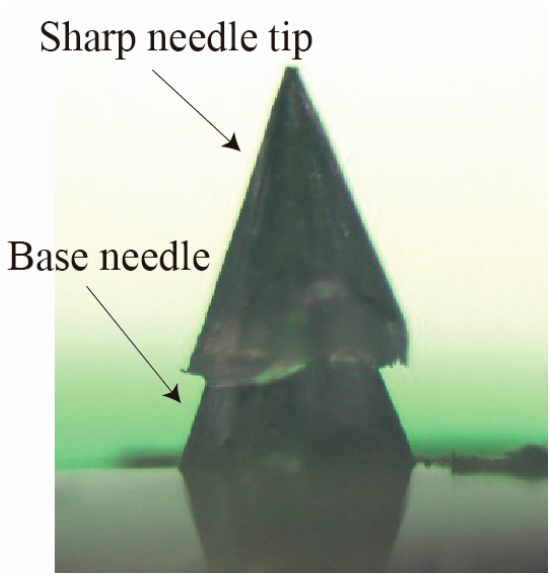
Figure 4. Produced tip-separable microneedle device.